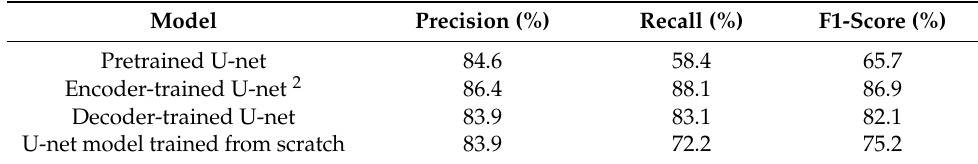
Table 3. Performance metrics of various U-net models on new test dataset (target domain 1